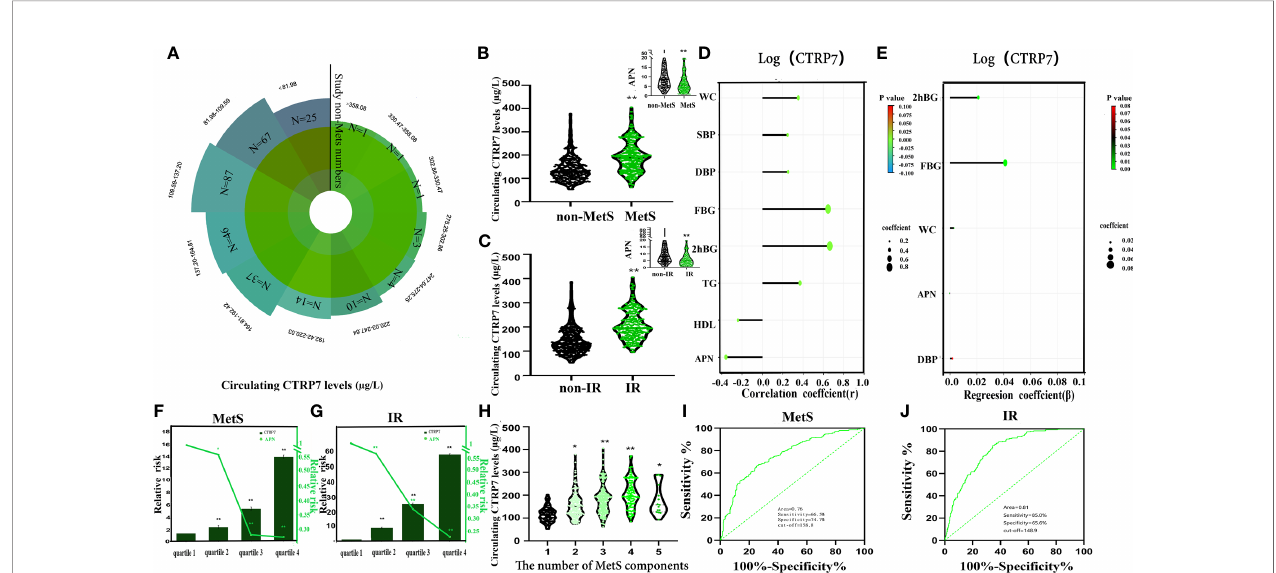
FIGURE 1 | Circulating CTRP7 level and its relationship with metabolic markers and Mets in the study population. (A) Distribution of serum CTRP7 in the healthy population. (B) Serum CTRP7 and APN levels in MetS and healthy subjects. (C) Serum CTRP7 levels, according to HOMA-IR (IR, HOMA-IR > 3; non-IR, HOMA-IR ≤ 3). (D) Simple correlation analysis of variables associated with circulating CTRP7. (E) Multiple regression analysis of variables associated with circulating CTRP7. (F, G) The odds ratio of having MetS (F) and IR (G) in different quartiles of serum CTRP7 and APN. (H) Circulating CTRP7 levels to the number of MetS components. (I, J) ROC curve analyses for the prediction of MetS (I) and IR (J) according to serum CTRP7 levels. MetS, metabolic syndrome; IR, insulin resistance. Data are expressed as mean ± SE or median (Interquartile Range). * p < 0.05, ** p < 0.01 vs. non-MetS or non-IR. quartile 1 or number 1.